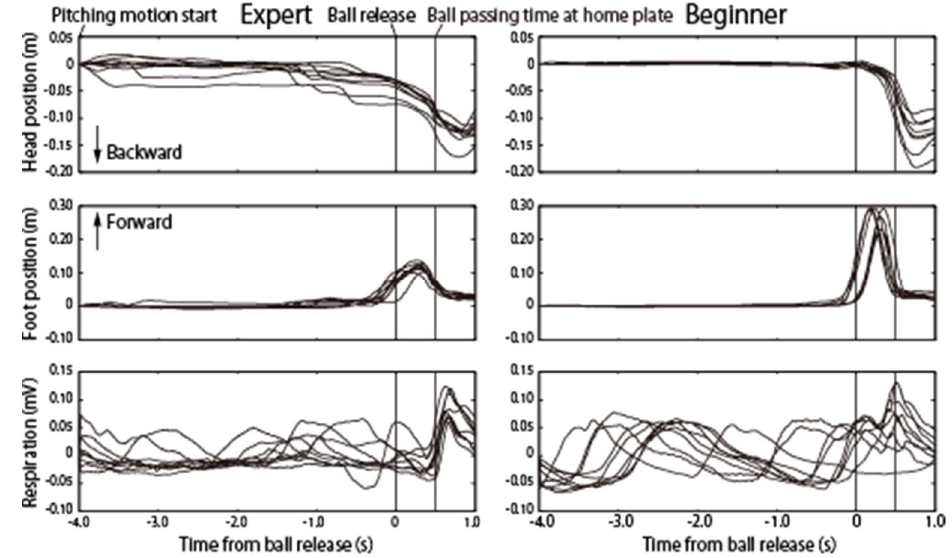
Figure 2. Examples of movement and respiration waveforms during fastballs with strikes in virtual baseball batting in an expert and a beginner